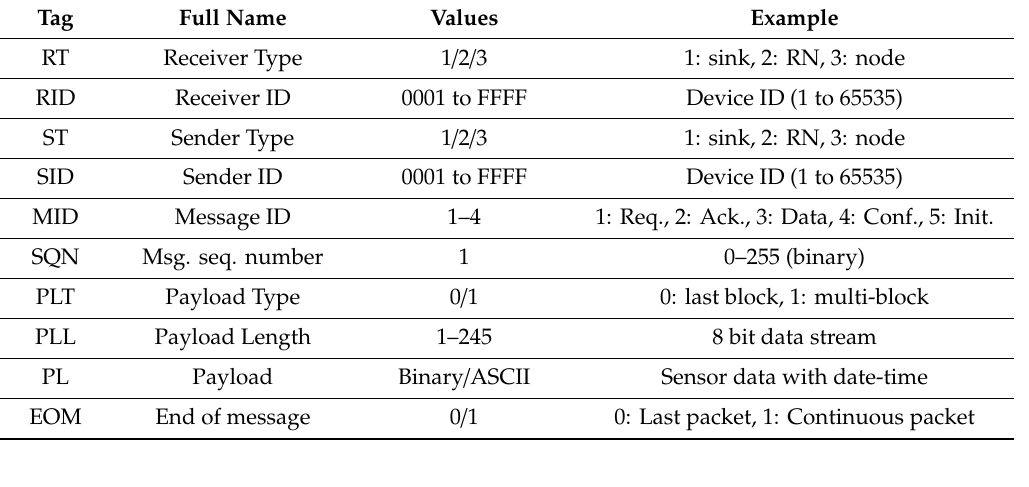
Figure 4. Implemented message format of LDAP. Table 3. IoT-WARM Communication packet description of LDAP.